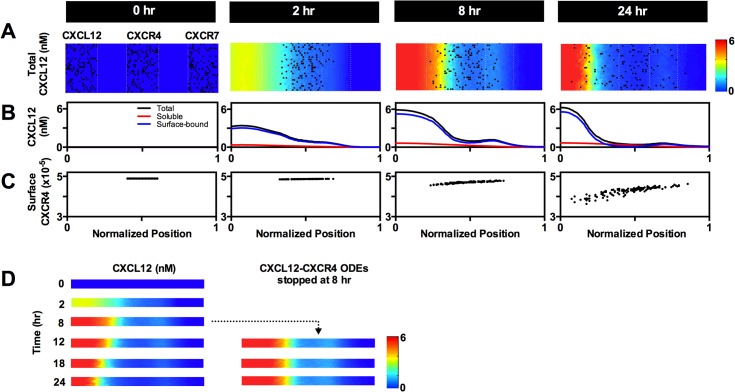
Multi-scale model predicts cell movement, molecular-scale information, and gradient formation within the microfluidic source-sink device.(A) Heat maps depict CXCL12 concentration in the agent layer and are overlaid with agent positions. Initial patterning of CXCL12+, CXCR4+ and CXCR7+ cells is shown at 0 hr. CXCL12+ and CXCR7+ cells, which move randomly, are not shown at later time points for clarity. Concentration values are averaged from 30 simulations. Cell positions shown are from one representative simulation. (B) Contribution of surface-bound (blue) and soluble (red) CXCL12 on total CXCL12 (black) concentration. At 0 hr, all concentrations are 0 nM. Concentration values are averaged from 30 simulations. (C) Number of CXCR4 surface receptors (sum of free, ligand-bound and β-arrestin-bound CXCR4) per individual CXCR4+ cell is plotted at the cell’s position across the width of the device. Data are shown for one representative simulation, the same simulation used for cell positions in (A). (D) Heat maps depicting CXCL12 concentration when CXCL12-CXCR4 binding and internalization ODEs are turned off at 8 hrs. All simulations depicted here were run with parameters from Table A in S1 File. Normalized position of 0 to 1 corresponds to the device width of 0.5mm to 1.5mm.